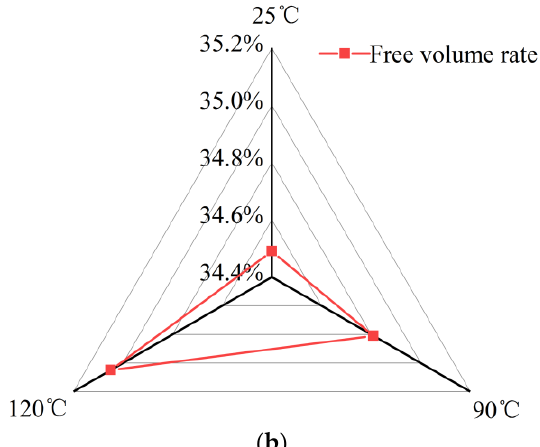
Figure 7. Molecular simulation results. ( a ) Free volume model of XLPE; ( b ) free volume rate of XLPE molecules at different temperatures.